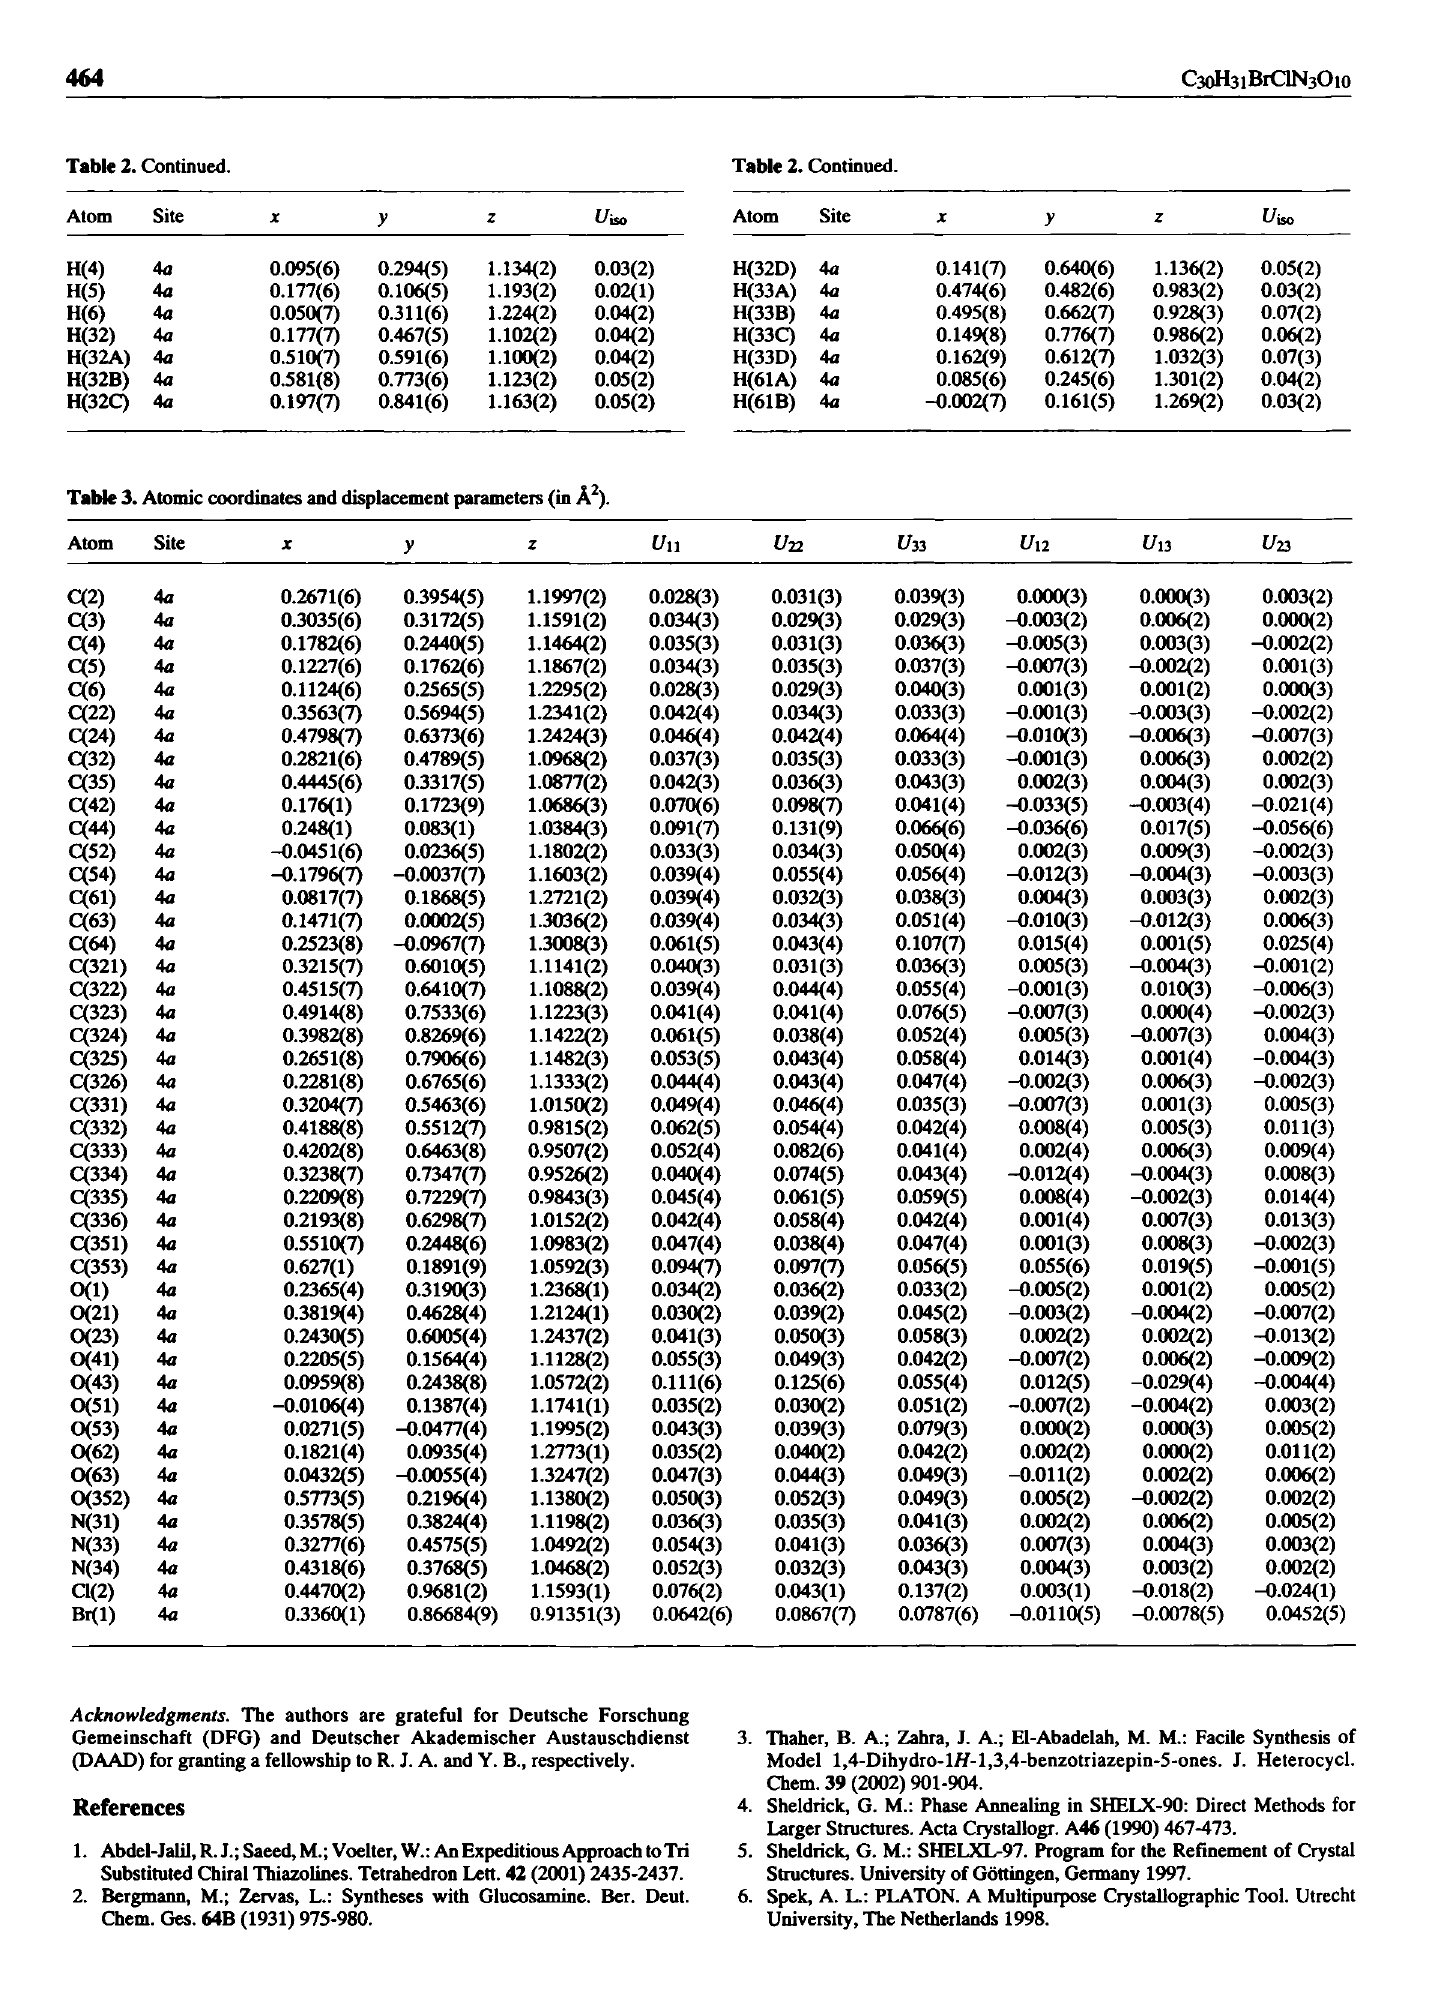
Table 3. Atomic coordinates and displacement parameters (in A 2